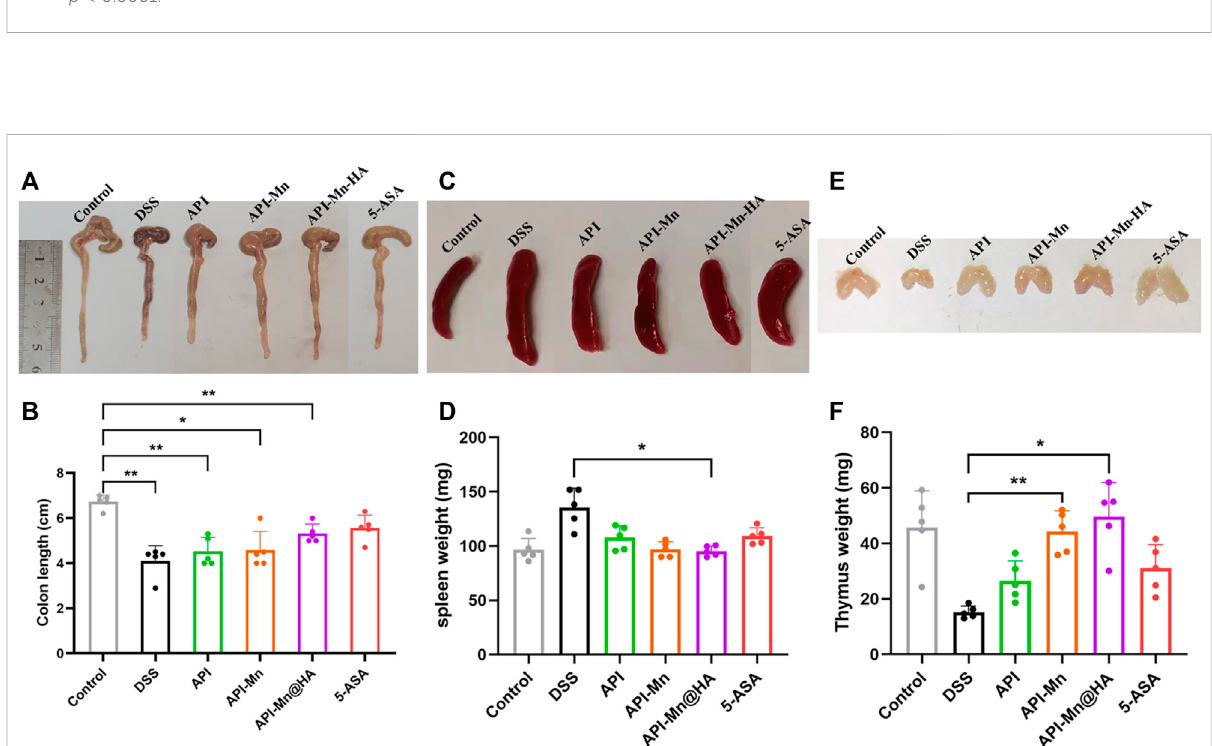
mice.Healthiermicehavelongercolons,lighterspleensandheavierthymuses. (A,B) Comparisonofcolonlengthinallthegroups. (C,D) Comparison of spleen weight in all the groups. (E,F) Comparison of thymus weight in all the groups. Results in 5-ASA group and API-Mn@HA group are much better compared with that of DSS group. Data are shown as mean ± SD. n = 5, * p < 0.05, ** p < 0.01, *** p < 0.001 and **** p <